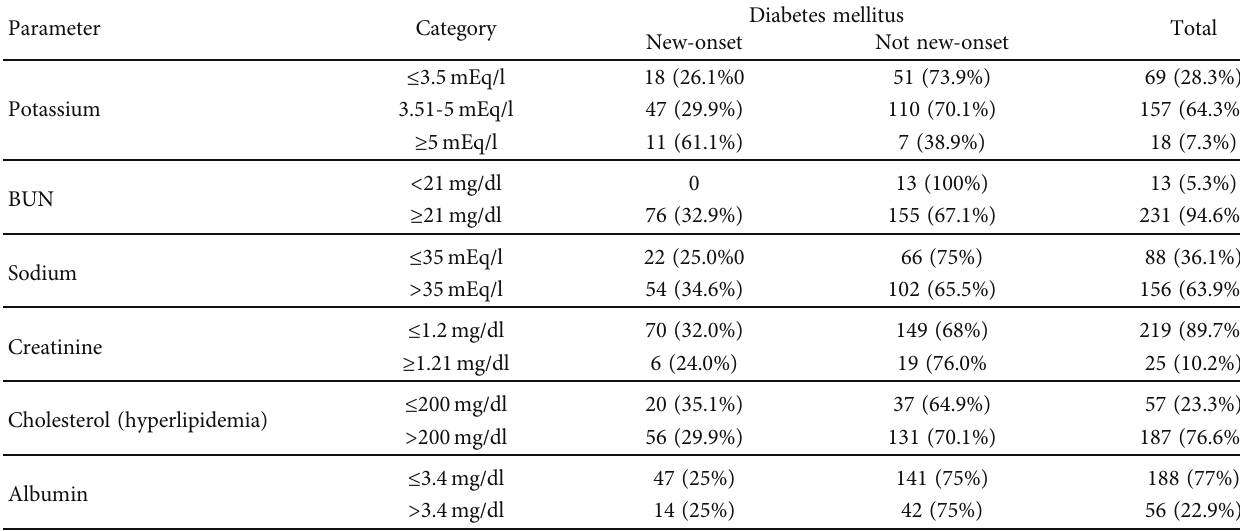
Table 2: The result of a laboratory investigation of the study participants at the COVID-19 care center in Addis Ababa, Ethiopia, in 2022 ( N = 244 ).